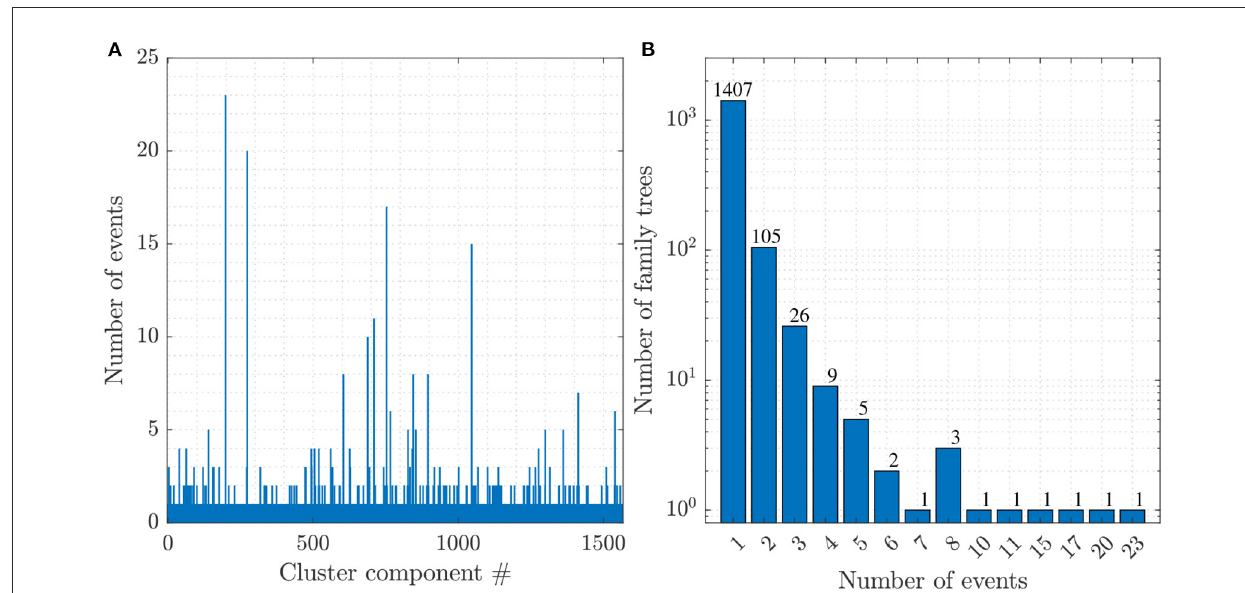
FIGURE10 Cluster statistics is shown for (A) the number of events in each cluster and (B) the distribution of clusters according to the number of